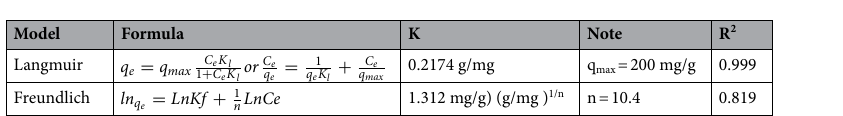
Table 4. Summary of experimental adsorption data fitted to the Langmuir and the Freundlich isotherm models.